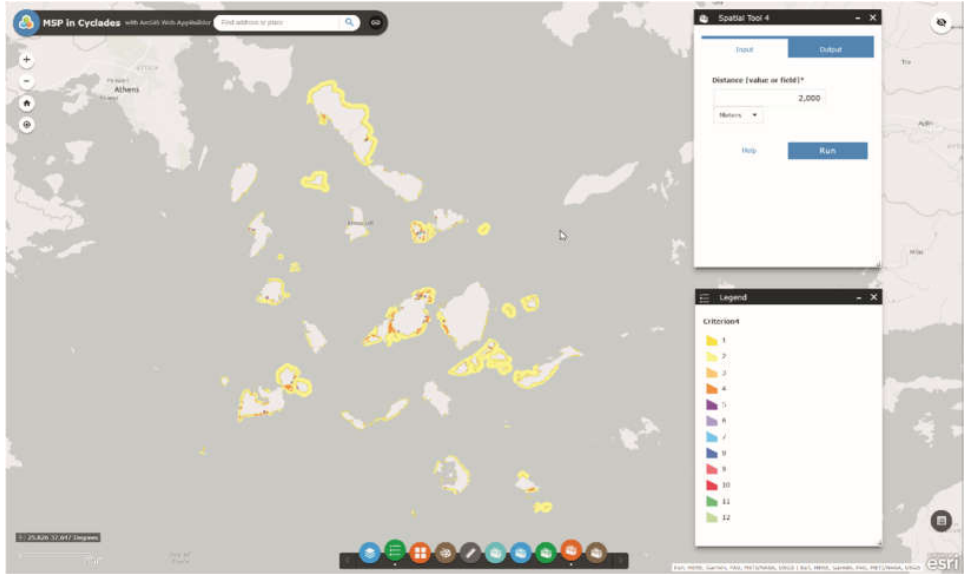
Figure 6. Conflicts within 2 km from the coastline.